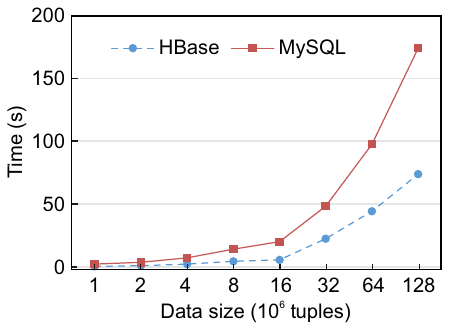
Fig. 9 Comparison with MySQL-based